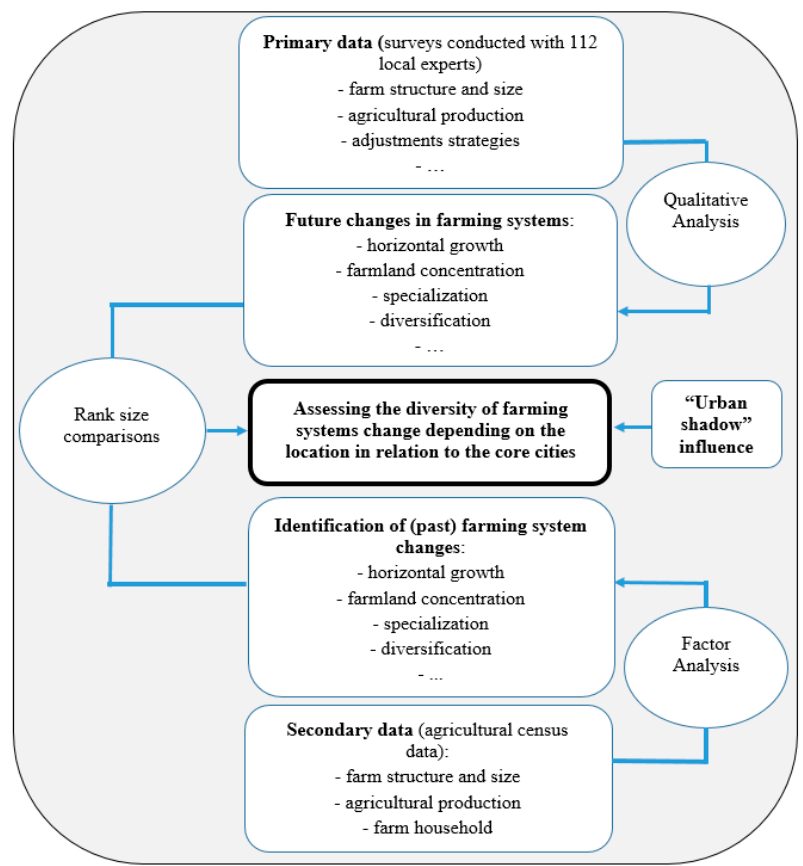
Figure 3. Analytical framework. Source: own elaboration.